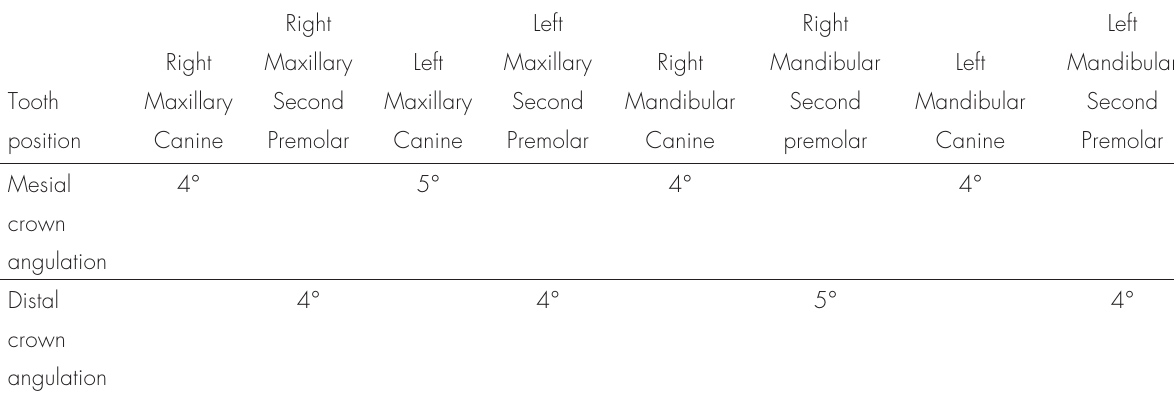
Table II. The overcorrection: extra crown